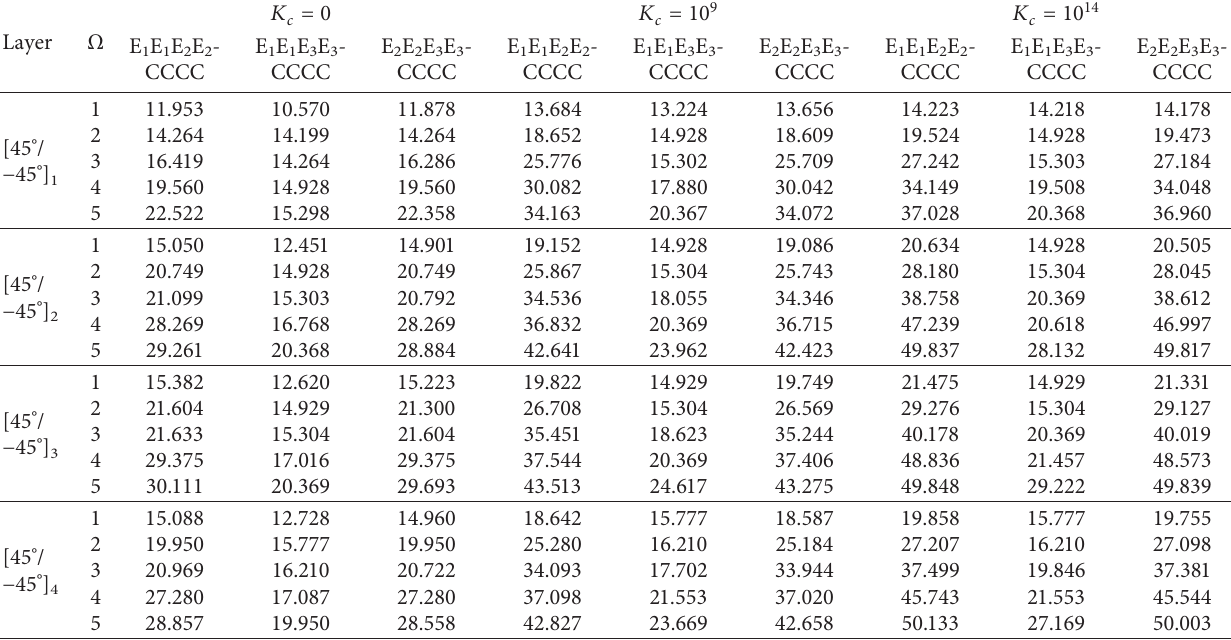
Figure 5: The lowest four mode shapes for an LCDPS with several conditions. Table 6: Frequency parameters Ω for an LCDPS with different middle spring parameters, layer scheme, and elastic